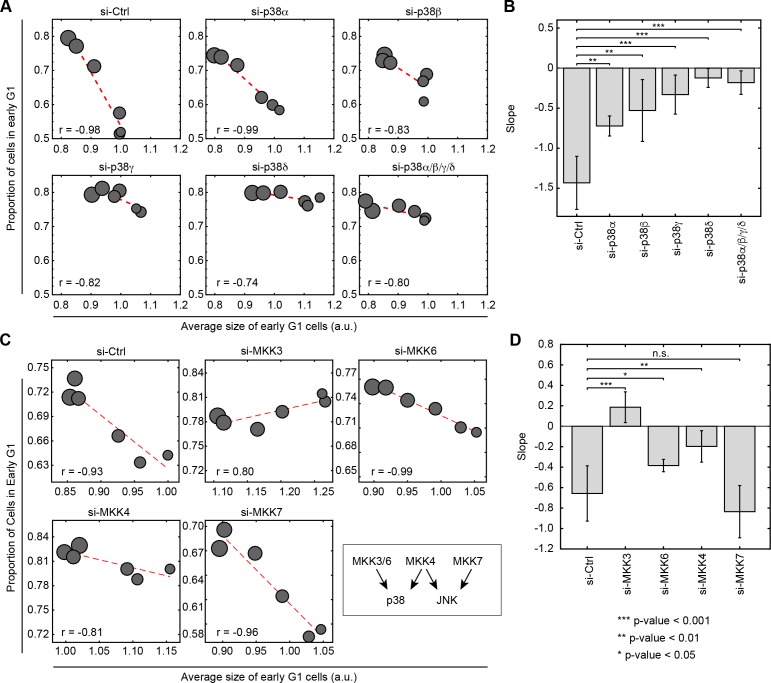
Knockdown of p38 pathway components disturbs the negative correlation between cell size and proportion of cells in G1.Cells were transfected with siRNA as indicated and subsequently assayed with a rapamycin concentration series (0, 0.03, 0.1, 0.3, 3 and 30 nM) as described in Figure 2A to assay the correlation of size and G1 length. Larger circle size indicates higher concentrations of rapamycin. (A) Knocking down p38α/βpartially weakens the negative correlation between cell size and proportion of cells in G1, while knockdown of p38γ/δ drastically disturbs the correlation. (C) The negative correlation between cell size and proportion of cells in G1 is disturbed when cells are transfected with siRNA against MKK3/4/6 but not MKK7. Each data point in Figure 4A and C is measured on an unsynchronized population with a minimum of 3000 cells. The results shown in Figure 4A and C are representative of two and three independent experiments with duplicates or triplicates. (B, D) Fitted slopes of the trends shown in Figure 4A and C. Error bars indicate 90% confidence intervals. Analysis is performed with the same method as indicated in Figure 2E. The meta data and source code to analyze and visualize the genetic knock down results is presented in Figure 4—source data 1.10.7554/eLife.26947.027Figure 4—source data 1.Binding activity (Kd’s in nM) of the p38 inhibitors used in the study against each of the p38 isoforms.Kd values in the table were extracted from Davis et al. (2011). As marked in that paper, blank fields indicate combinations that were tested, but for which binding was weak (Kd >10 μM), or not detected in a 10 μM primary screen.10.7554/eLife.26947.028Figure 4—source data 2.Measurements of cell size and cell cycle stage from the knockdown experiments as shown in Figure 4.